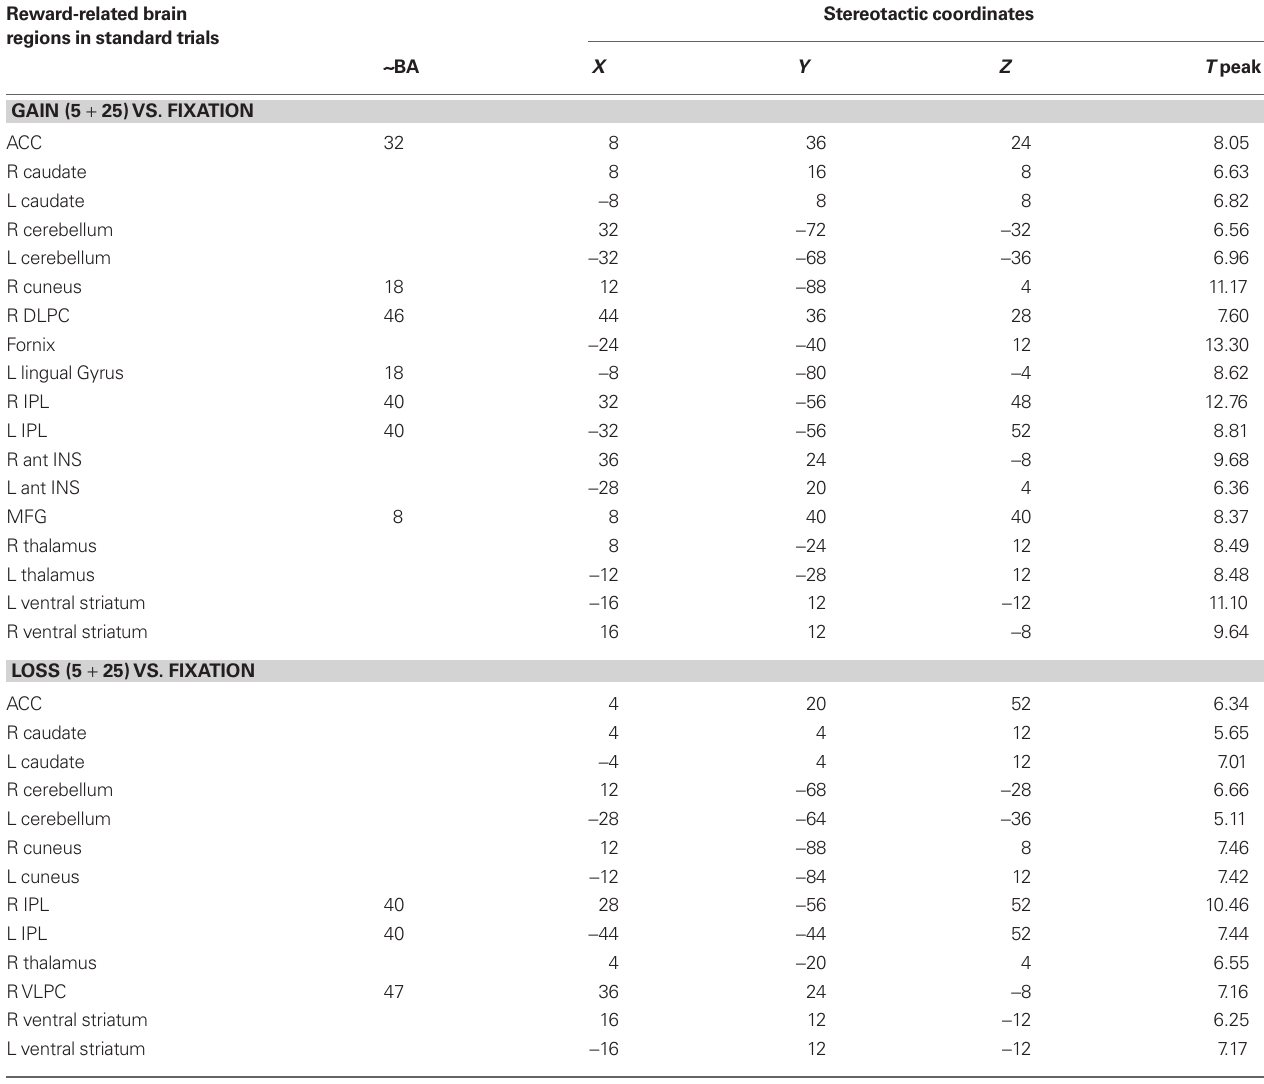
Table 2 | Main effects for gains, losses, and gains vs. losses for standard trials in the classical functional analysis. Reward-related brain Stereotactic coordinates regions in standard